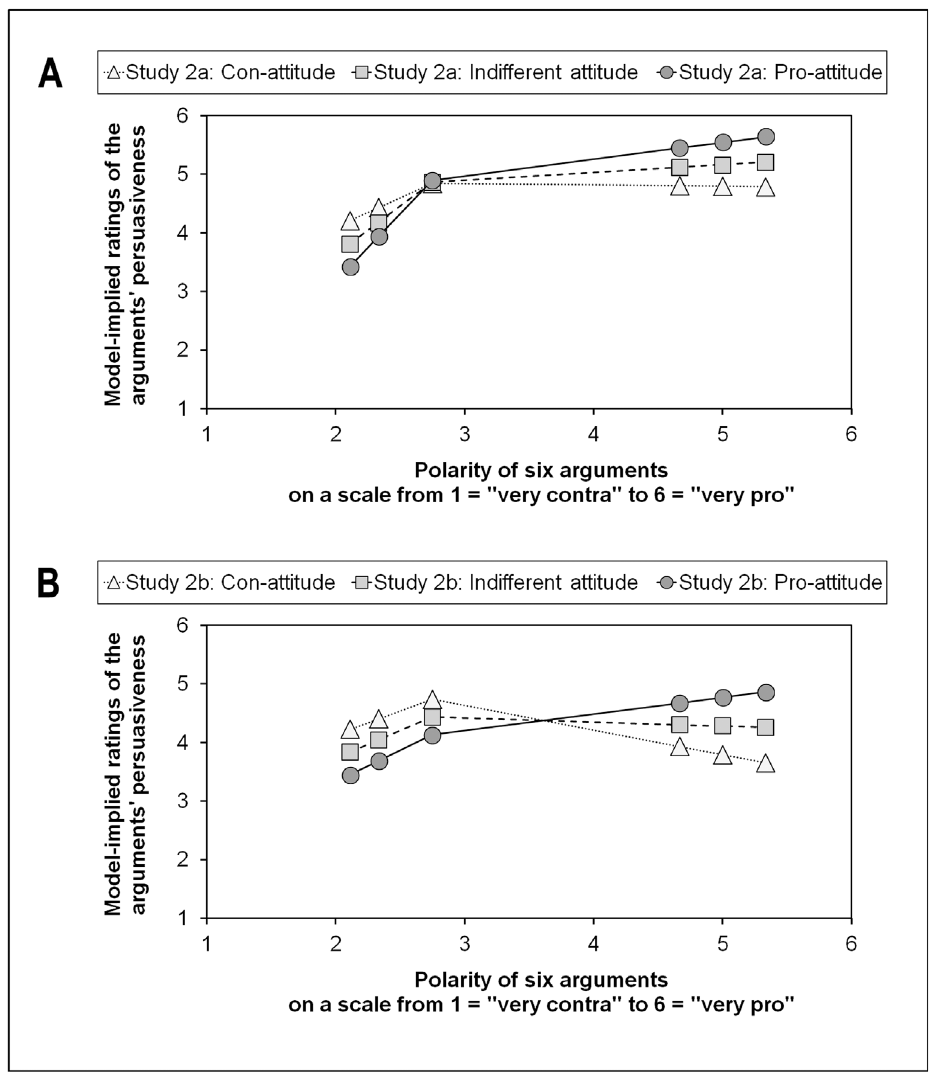
Fig 5. Piecewise growth curves: M-learning. (A) Study 2a. (B) Study 2b.